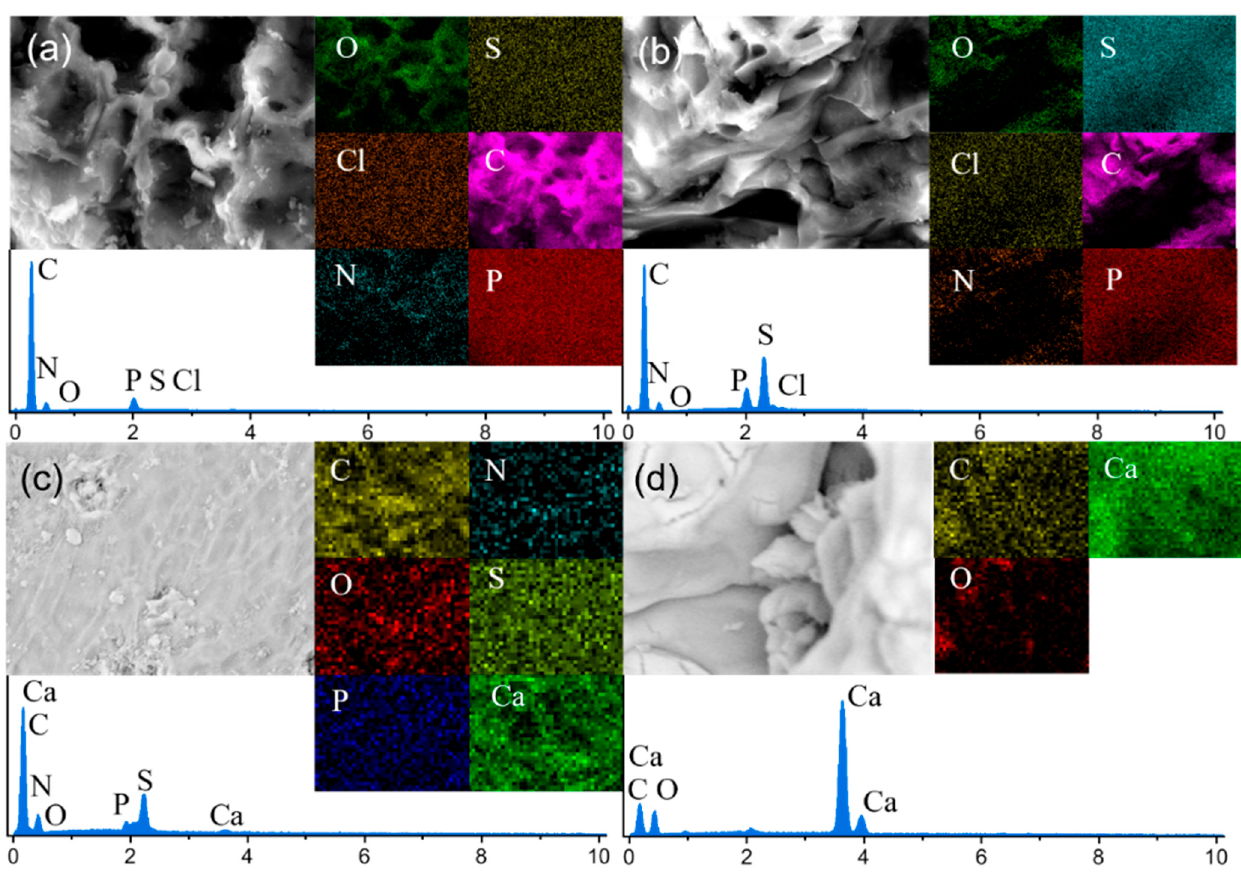
Figure 4. EDS images of ( a ) CN before adsorption, ( b ) CN after adsorption, ( c ) MCS3 ‐ 1 after adsorption, and ( d ) SS. Table 1. Elemental content of CN before and after adsorption, MCS3 ‐ 1 after adsorption, and SS.